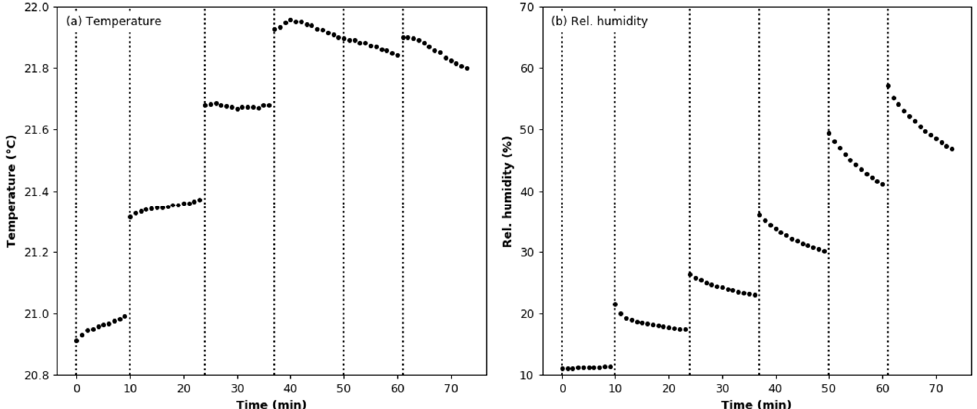
Figure 14. Environmental conditions during the soot effect test under variable humidity conditions: ( a ) air temperature; ( b ) relative humidity.